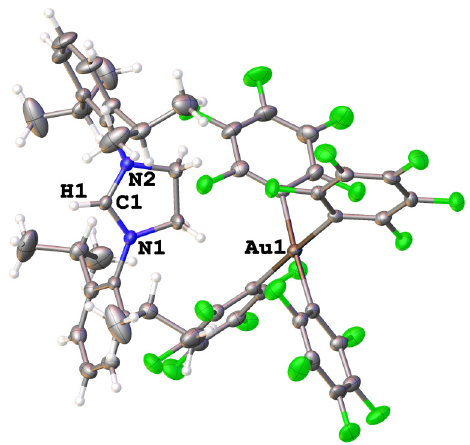
Figure 7. Solid structure of gold–imidazolium salt 4 with 50% probability ellipsoids. Selected bond lengths (Å) and angles (°): N(1)-C(1) 1.308(4), N(2)-C(1) 1.297(4), Au(1)-C(28) 2.044(3), Au(1)-C(34) 2.053(3), Au(1)-C40 2.059(3), Au(1)-C(46) 2.061(3); C(28)-Au(1)-C(34) 176.43(12), C(28)-Au(1)-C(40) 88.06(12), C(28)-Au(1)-C(46) 91.90(12), C(34)-Au(1)-C(40) 88.84(12), C(34)-Au(1)-C(46) 91.33(12), C(40)-Au(1)-C(46) 175.47(12).